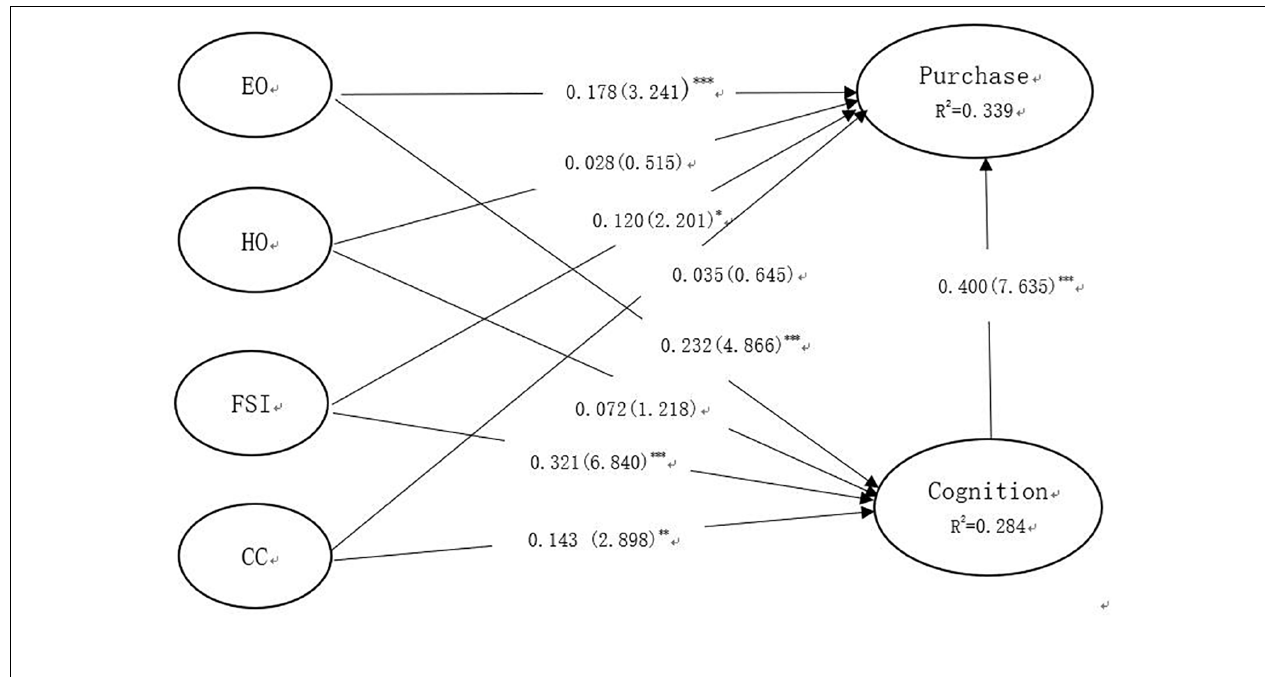
FIGURE 3 | Structural model analysis. ∗ p < 0.1; ∗∗ p < 0.01; ∗∗∗ p <